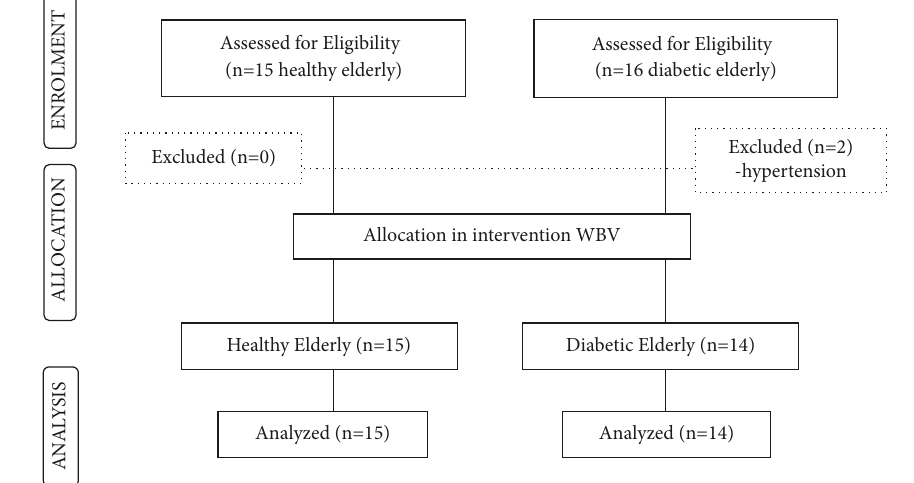
Figure 2: Flowchart of the study volunteers.